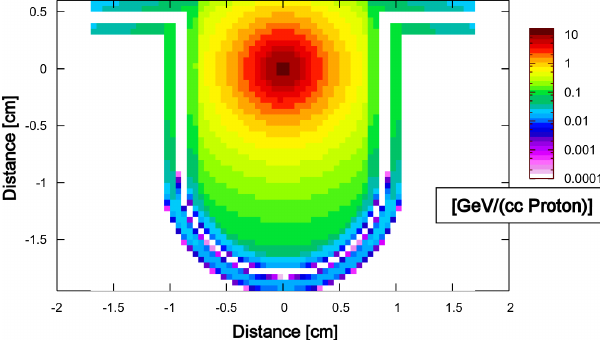
FIG. 9. Energy deposition in sample and titanium troughs for a 440 GeV, 2 mm beam